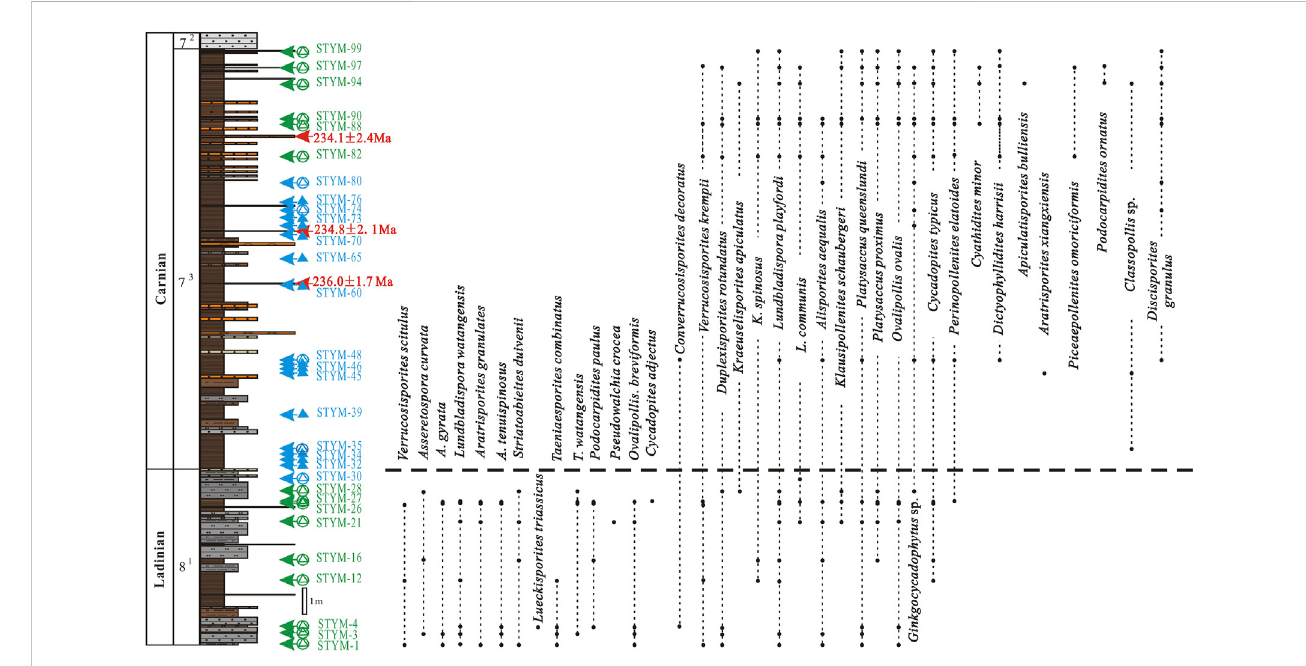
FIGURE 6 Distribution of selected palynological taxa during the Ladinian – Carnian transition in the Yunmeng pro fi le, Ordos Basin, China.